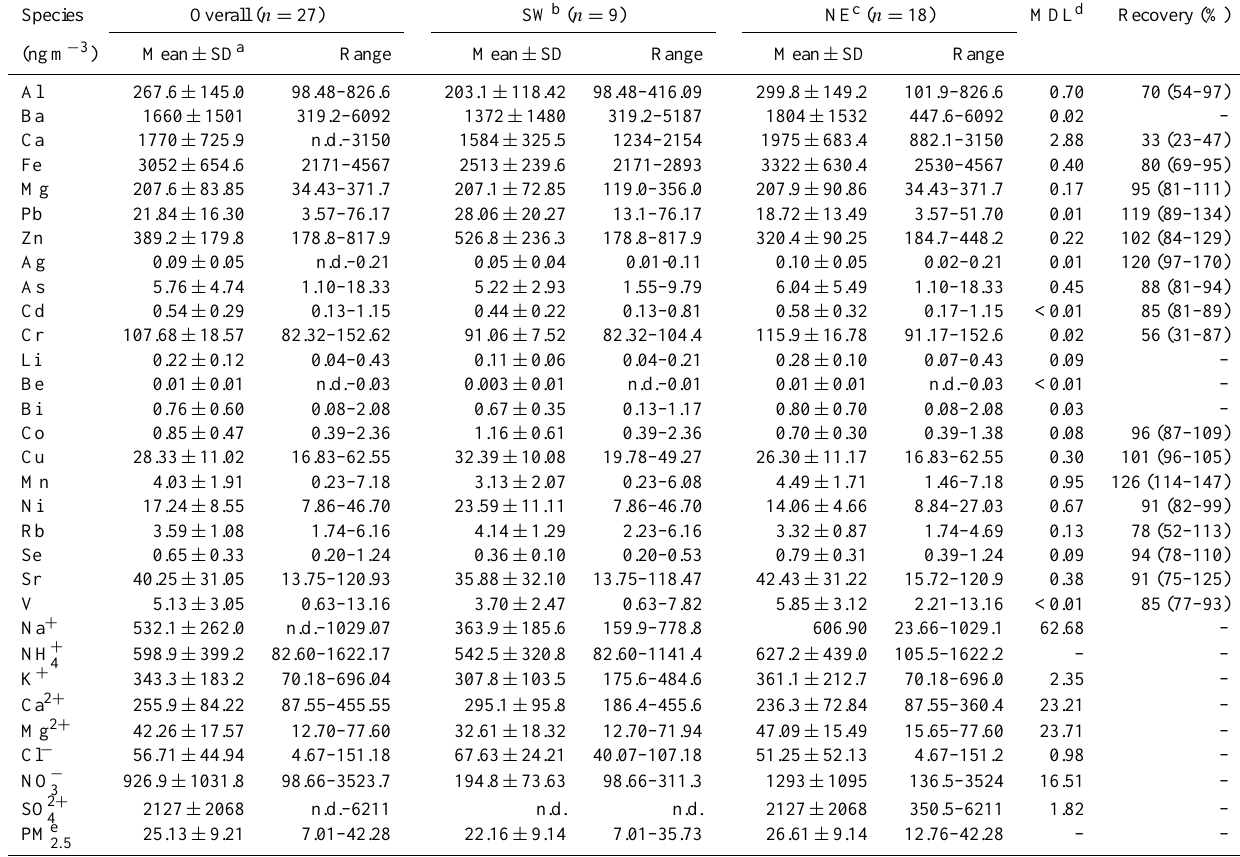
Table 1. The statistical parameters of the PM 2 . 5 and its compositions.